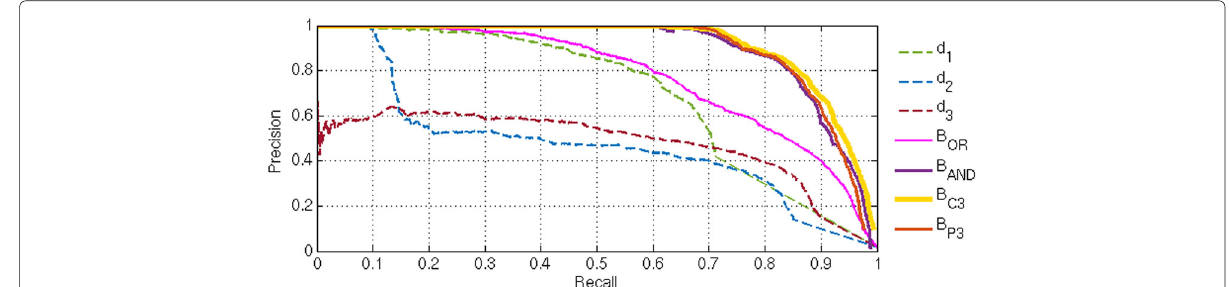
Fig. 10 P-R curves of BOA cascades. Precision vs. recall curves of detectors d 1 , d 2 , and d 3 and some BOA combinations of